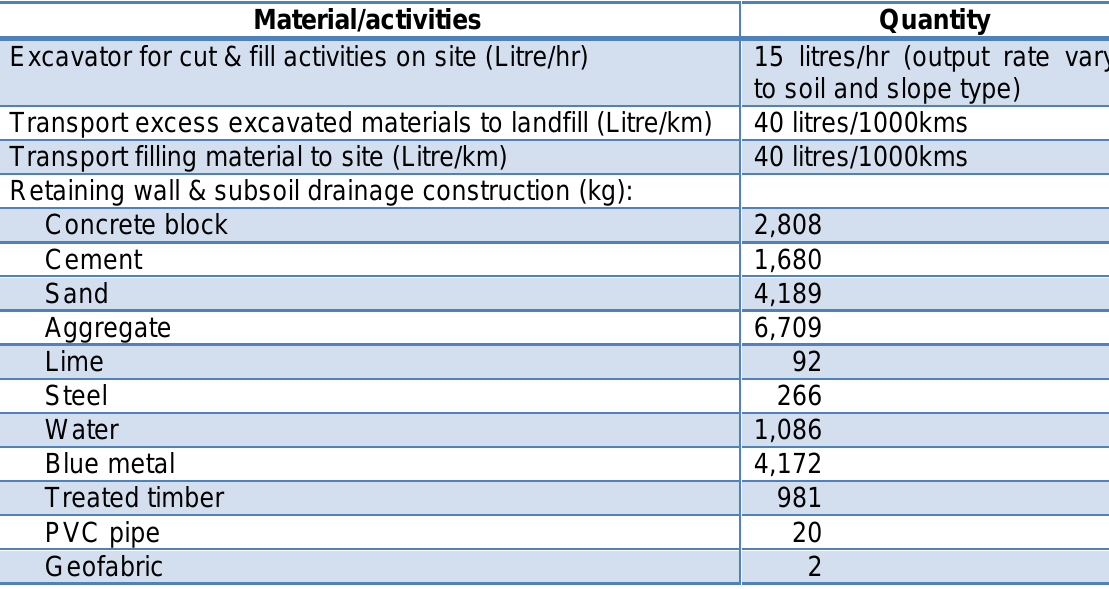
Table 2: Inventory data of key materials/activities for the study Material/activities